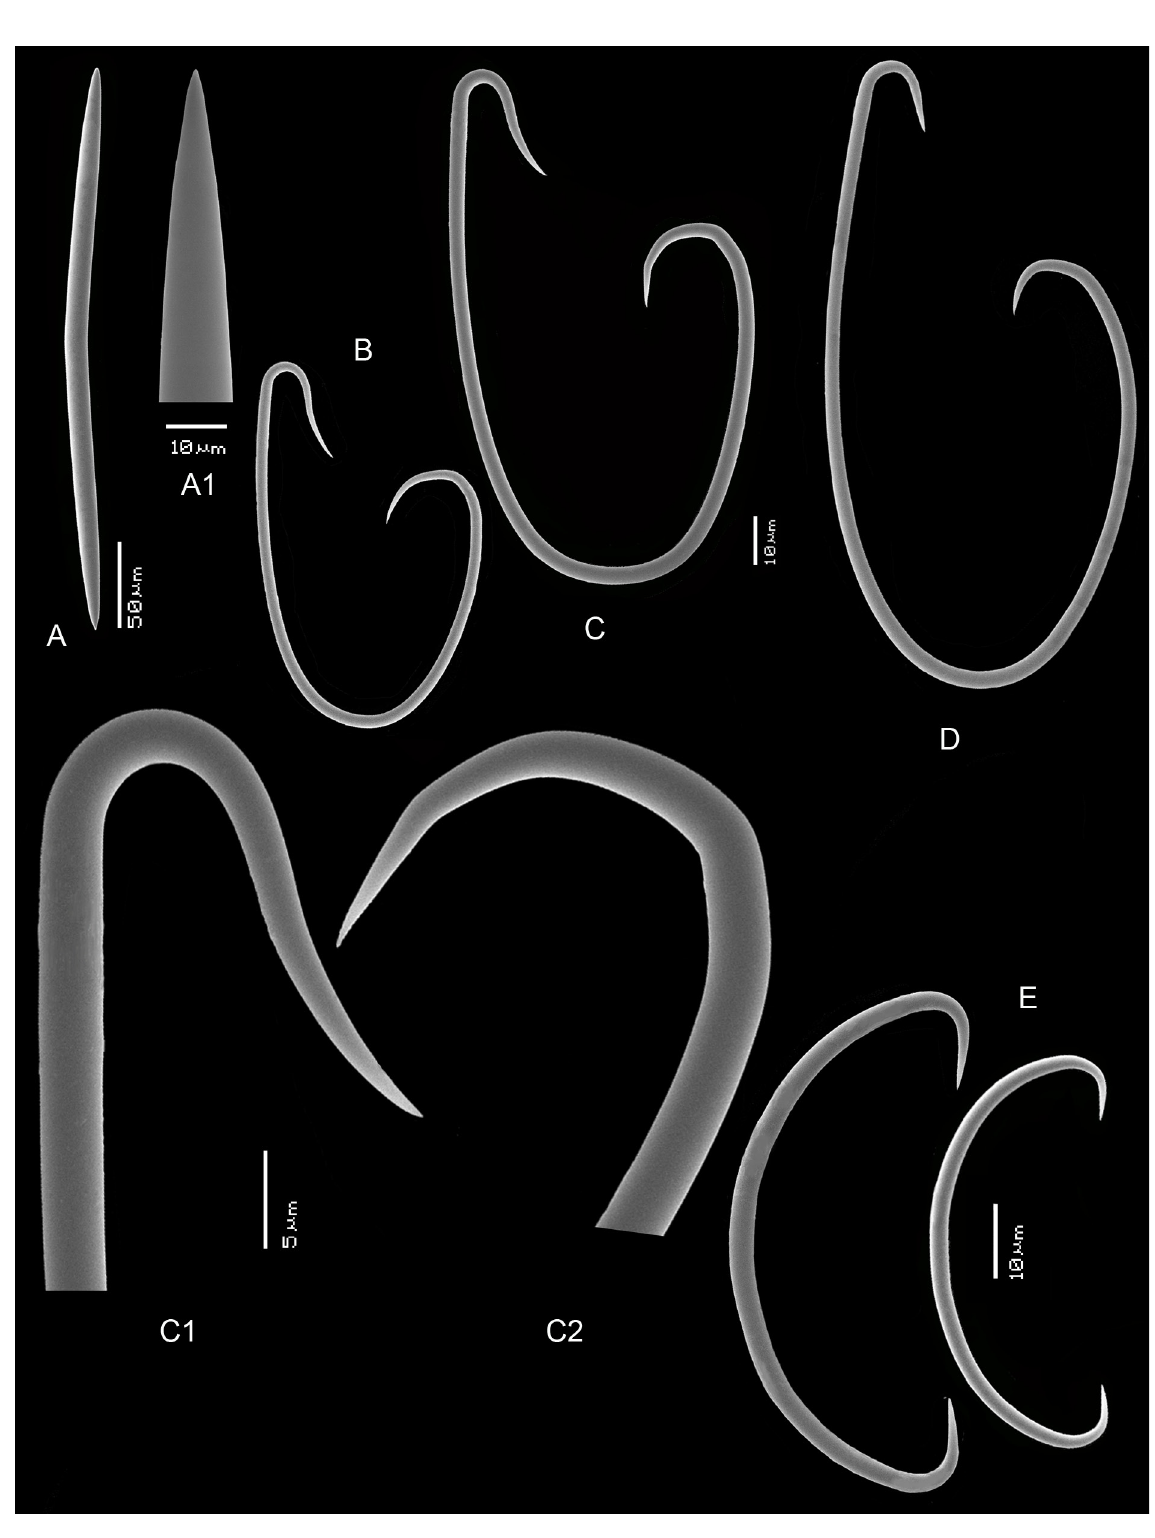
Fig. 16. Haliclona ( Flagellia ) hajdui subgen. et sp. nov., from the Guyana Shelf, off Suriname, holotype, SEM images of spicules (RMNH Por. 9921). A . Oxea. A C . Detail of long ending of flagellosigma. C 1